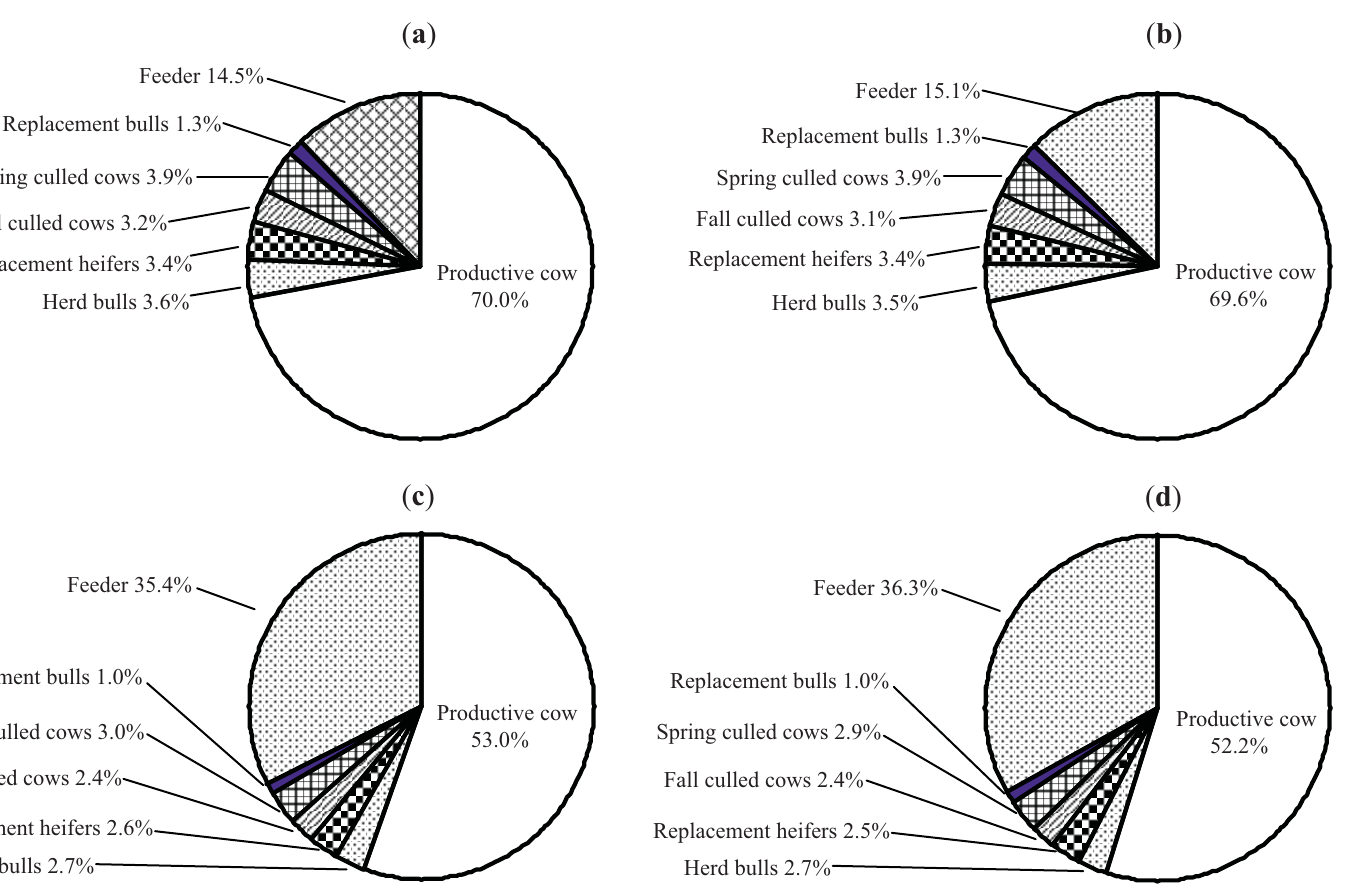
Figure 1. Breakdown of total greenhouse gas (GHG) emissions resulting from hormone free and growth implanted calf-fed and yearling-fed beef production systems (CO ) equivalents, 160 cow-herd assumed). ( a ) Calf-fed, Hormone Free Animal GHG emissions = 922,107 kg CO 2 ( b ) Calf-fed, growth implanted Animal GHG emissions = 928,344 kg CO e. ( d ) Yearling-fed, Growth Implanted Animal GHG emissions = 1,237,082 kg CO 1,219,659 kg CO 2